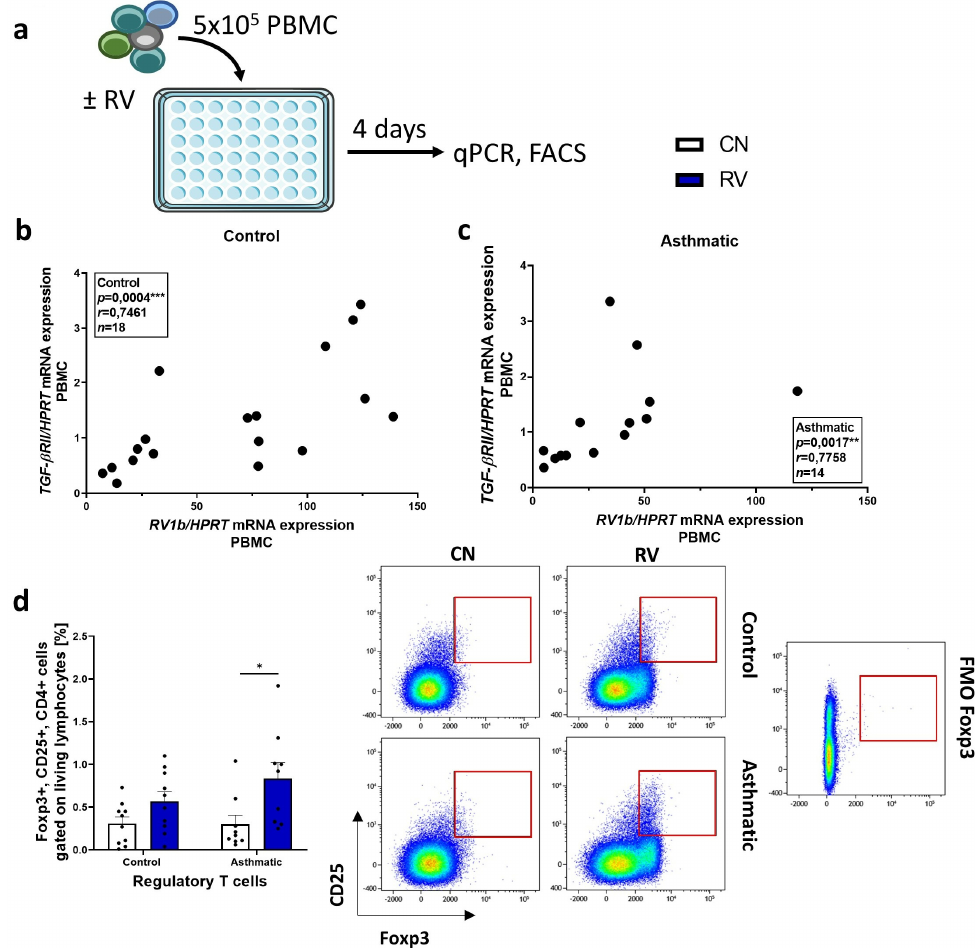
Figure 2. High rhinovirus load was associated with more TGF- β RII and induced Treg immune response. ( a ) Experimental design. ( b ) Correlation of TGF- β RII/HPRT expression in RV-infected PBMCs with the RV1b/HPRT mRNA expression in controls. ( c ) Correlation of TGF- β RII/HPRT expression in RV-infected PBMCs with the RV1b/HPRT mRNA expression in asthmatics. ( d ) Flow cytometry analysis of Foxp3+ CD25+ CD4+ Tregs in CN and RV condition. A representative dot plot of each group and the FMO control is shown ( n = 10, 9, 10, 9). Data are shown as Mean+SEM. * p < 0.05, ** p < 0.01, *** p <